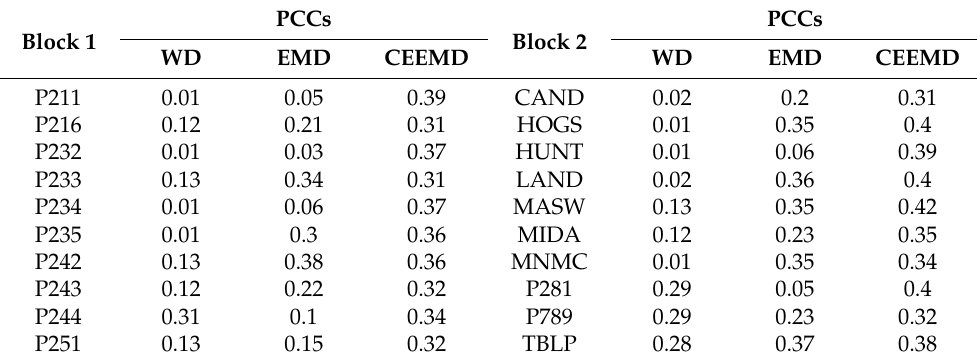
Table 5. Similarity of seasonal terms based on WD, EMD and CEEMD. Block